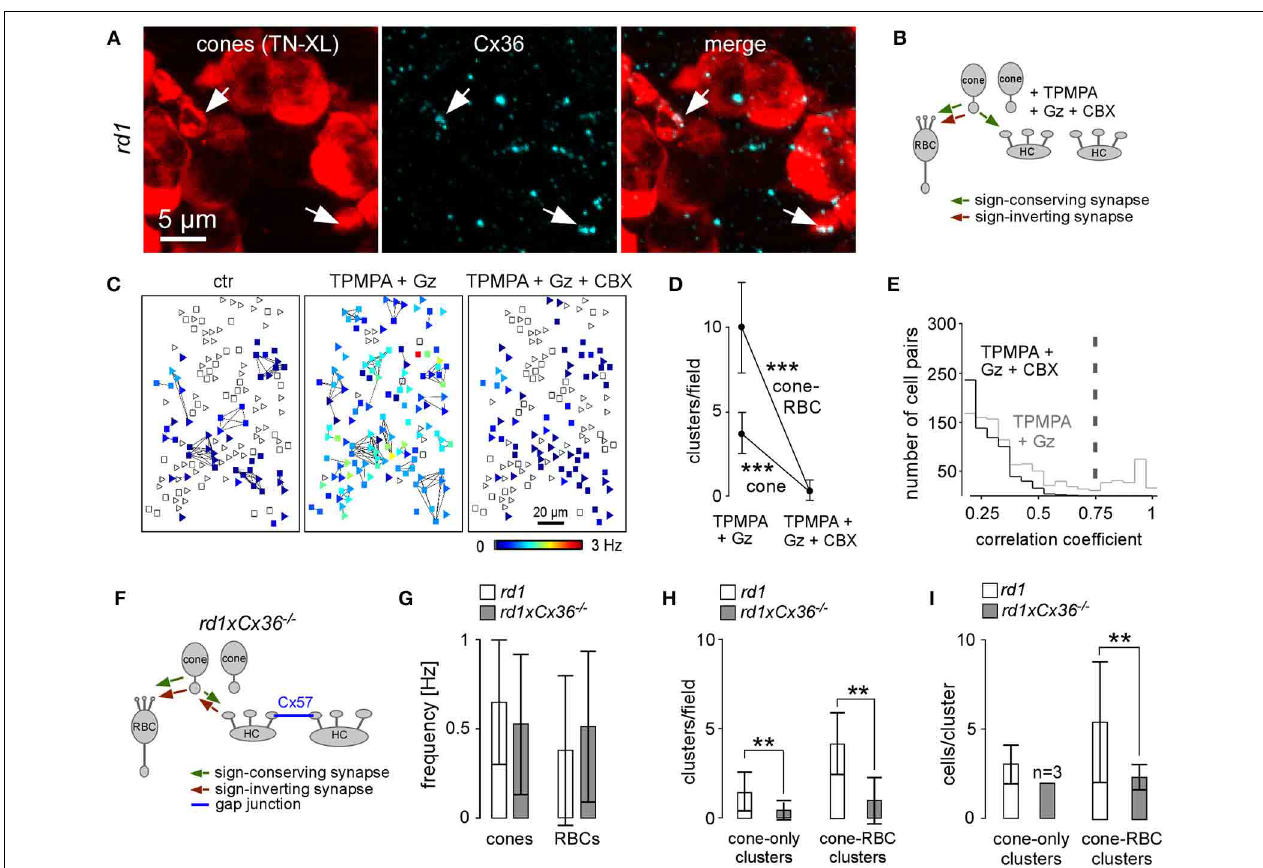
FIGURE 5 | Uncoupling of gap junctions between cones reduces correlated activity but not spontaneous activity. (A) Left: immunolabeling of a P30 rd1 wholemount retina showing cone somata (TN-XL, red) and smaller neurite protrusions. Middle: Cx36 immunolabeling (cyan) in same region. Right: overlay showing that cone neurite protrusions express Cx36 (arrows). (B) Drawing shows synaptic interactions with CBX blocking electrical coupling among cones and among HCs as well as possible ephaptic HC feedback. (C) Representative activity map before (ctr), with GABA receptor blockers (TPMPA + Gz), and with additional gap junction blocker CBX